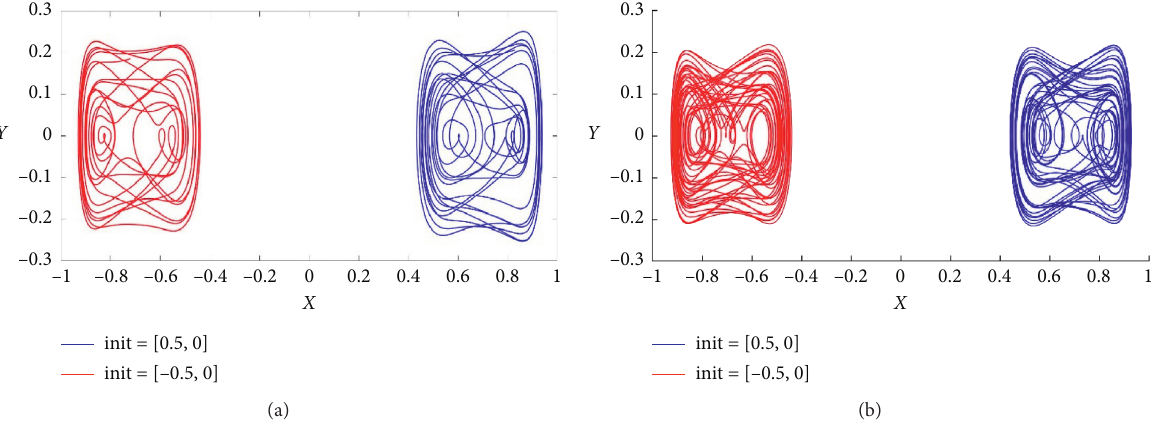
Figure 9: Phase portrait of system (7) for θ � 1 . 04 and c � 0 . 045. (a) η � 0 . 01; (b) η � 0 . 1. Remaining parameters are kept as in (9).